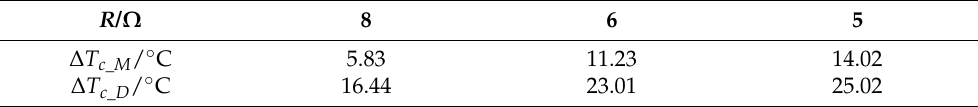
Table 1. The temperature differences of case temperature under different load resistances.